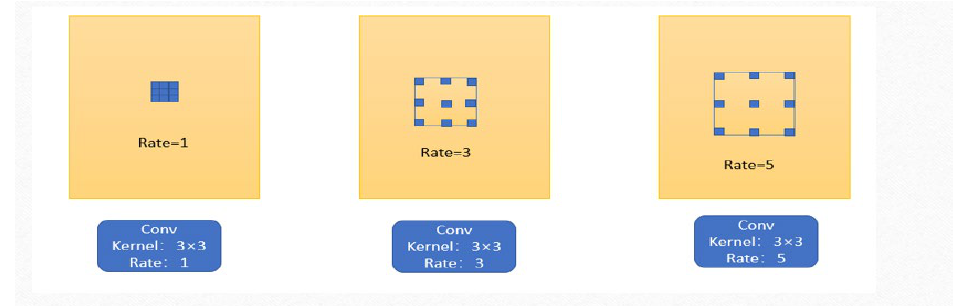
Figure 4. Schematic diagram of dilated